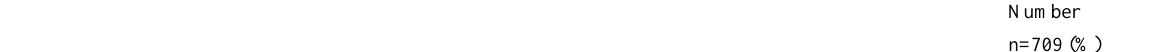
Table 2. Participants’ health service utilization, help-seeking behaviors, and experiences of physical and emotional well-being concerns during the